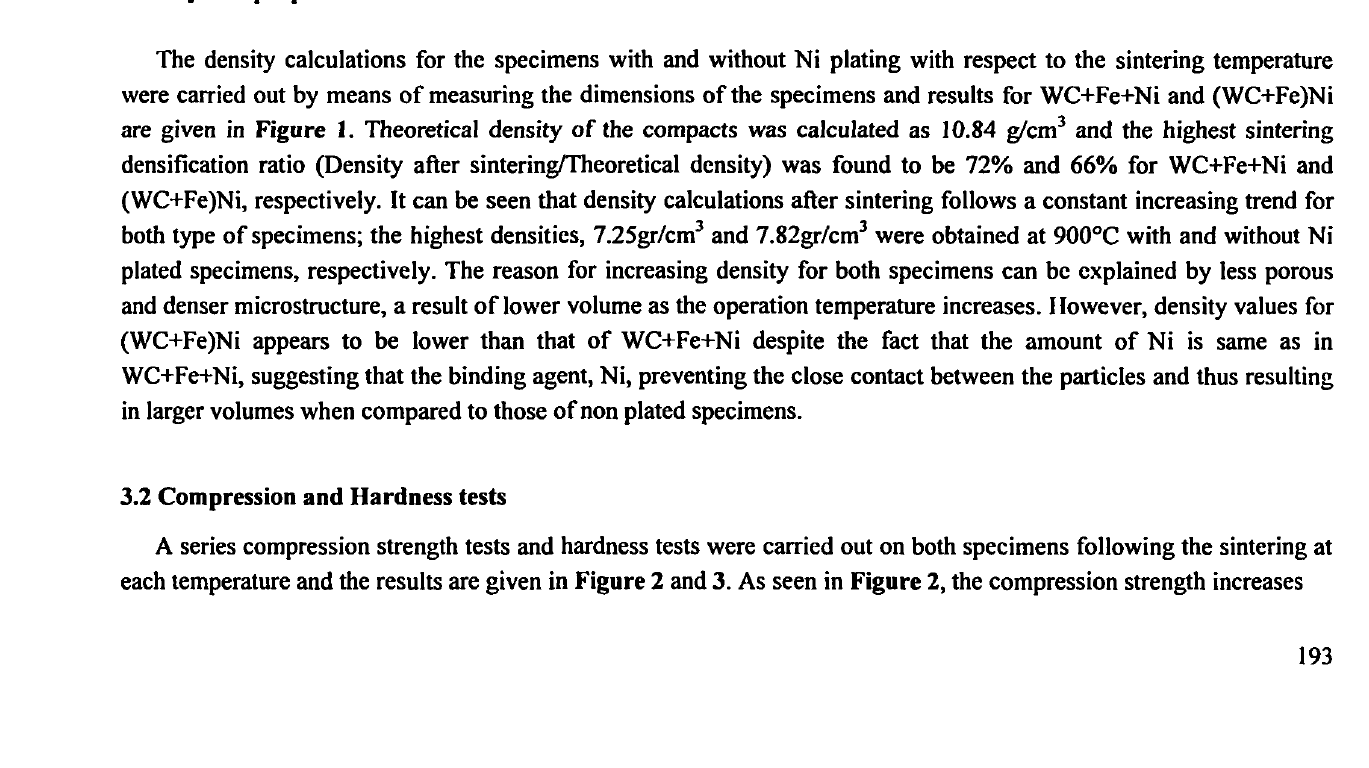
Fig. 1: Density-temperature curves for Ni plated and non Ni plated